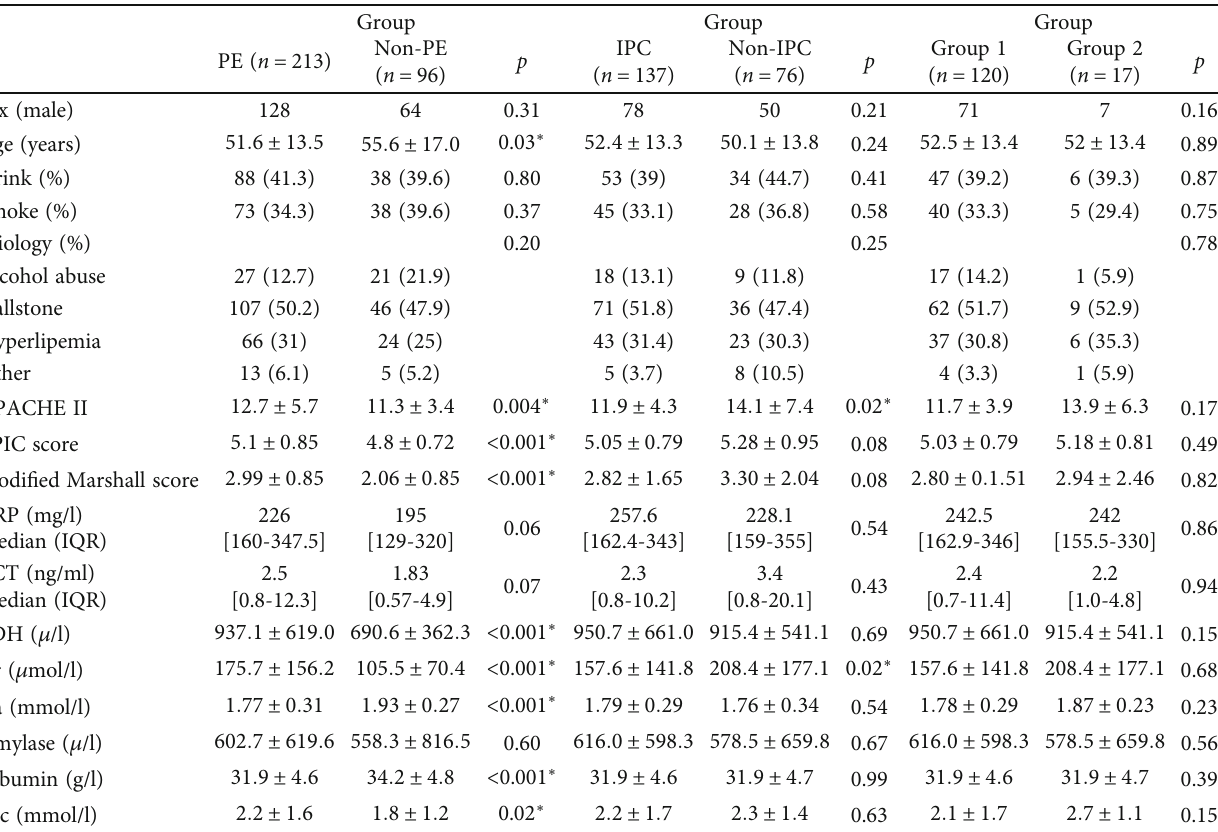
Table 3: Baseline characteristics of each two groups.